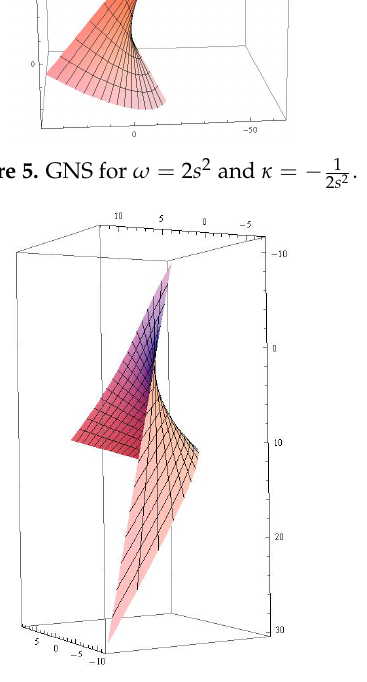
Figure 6. GNS for ω = 8 and κ = − 1